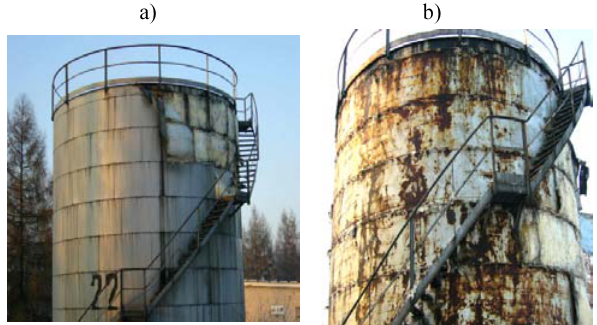
Fig. 3. Tank No. 22: a) during removal of insulation, b) corrosive changes on tank side surface after removal of protective